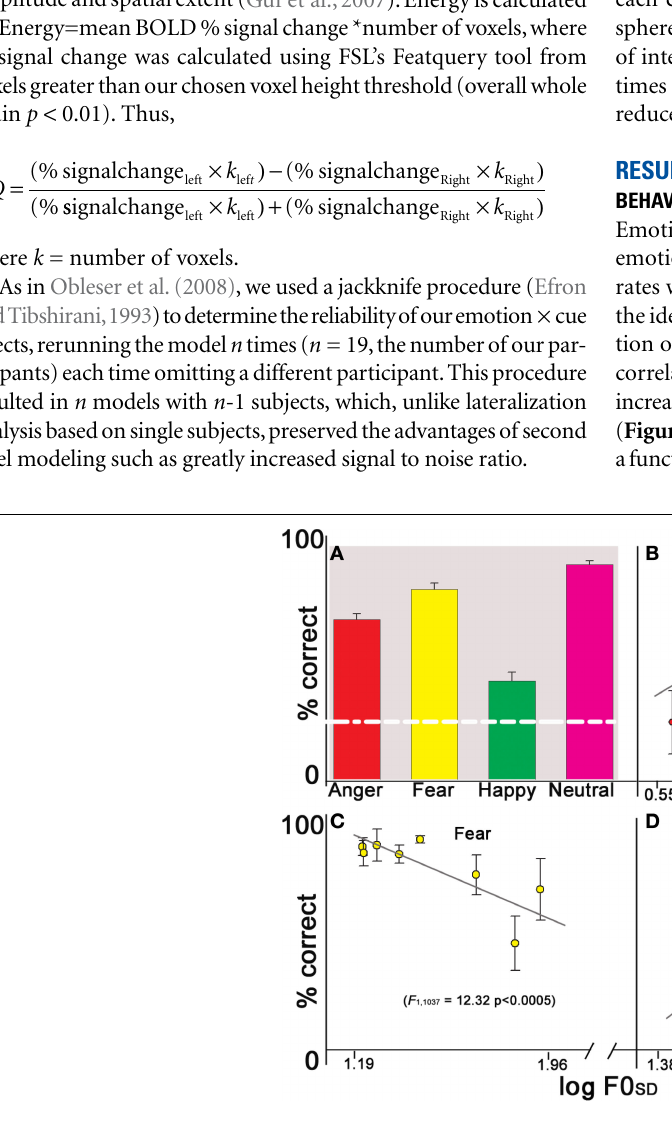
increases accuracy increases. (C) Fear: as F0 500 SD